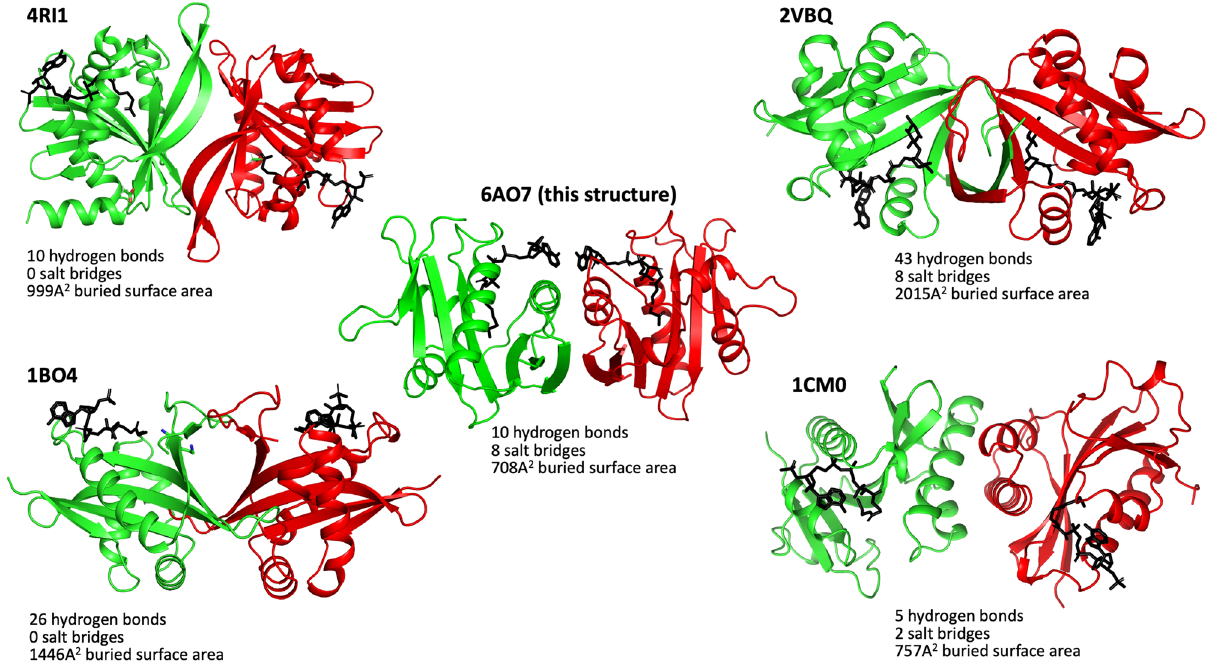
Figure 6. GNATs form a range of different dimers. Presented here are the 5 (including this dimer) different dimer structures. The PDB codes 4RI1, 2VBQ, 1BO4 and 1CM0, representing each different dimer are shown below each dimeric